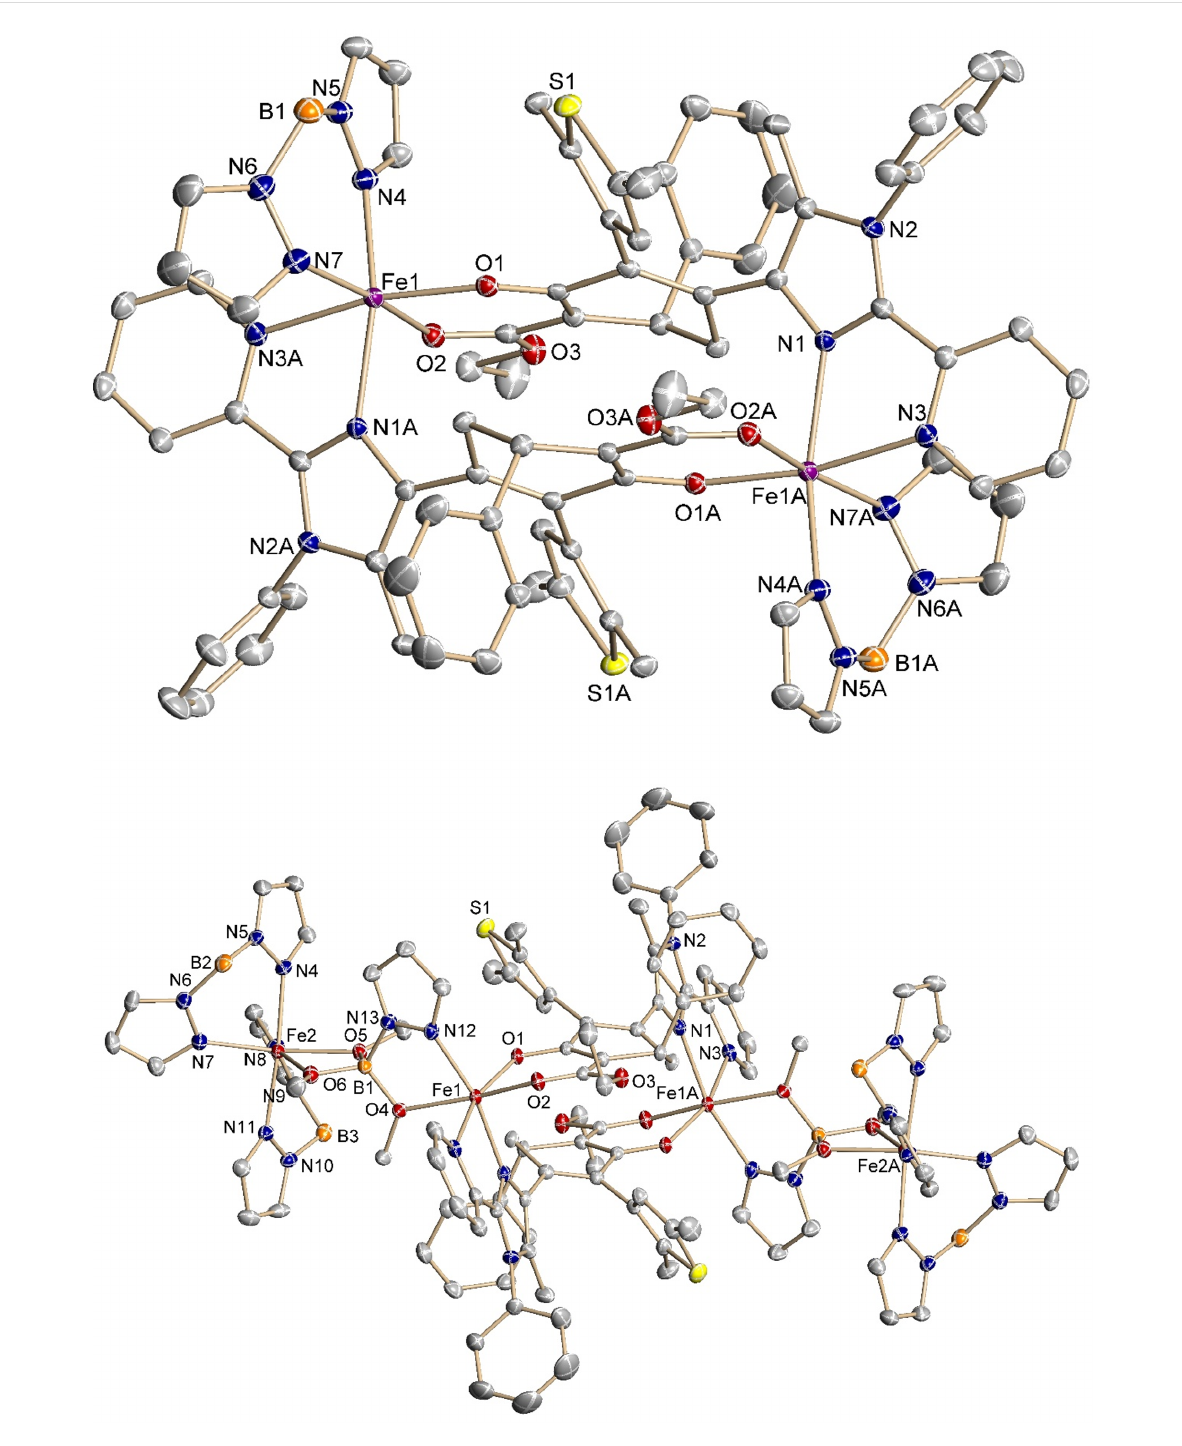
Figure 3: Molecular structure of complexes 8 (top) and 9 (bottom) at 100 K. The H atoms are omitted for clarity; the thermal ellipsoids are drawn at the 50% probability level.